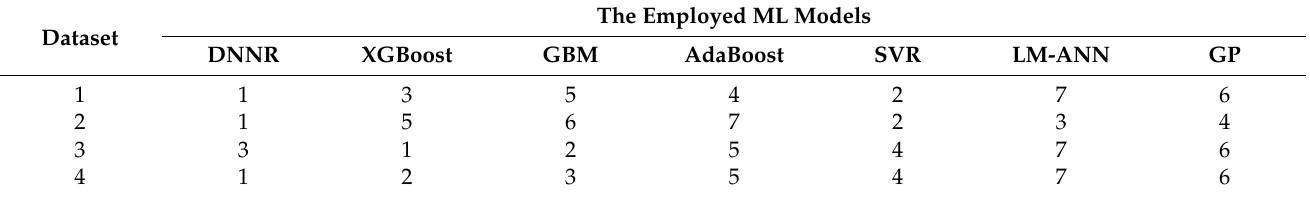
Table 9. Detailed model